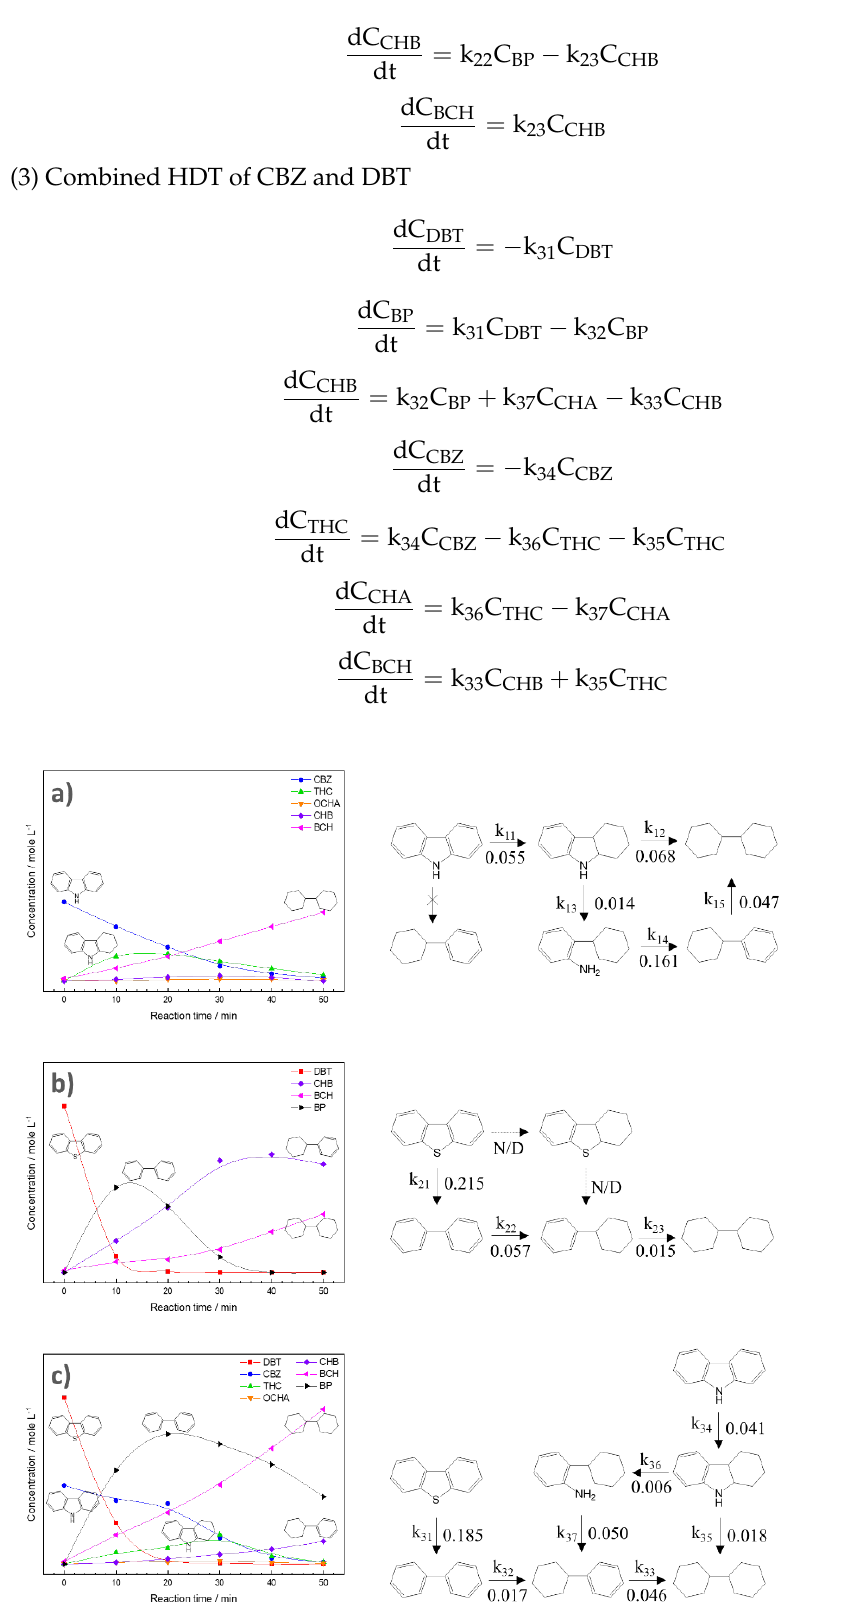
Figure 7. Concentrations of products as a function of time during HDS of DBT and HDN of CBZ over NiMoS: ( a ) HDN of 100 ppm N CBZ, ( b ) HDS of 500 ppm S DBT, and ( c ) Combined HDN and HDS of 100 ppm N CBZ and 500 ppm S DBT.